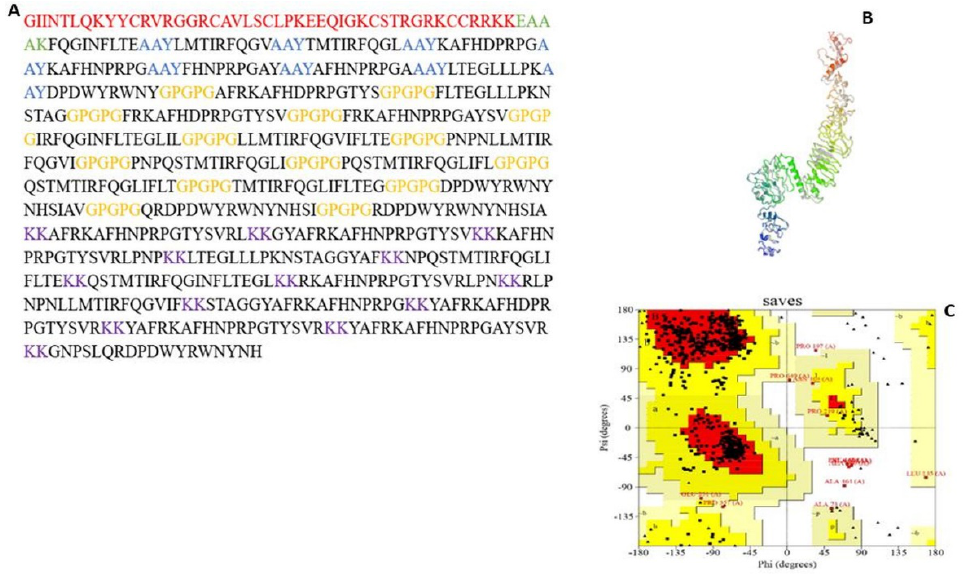
Figure 1. The 3D structure prediction and validation of MEVconstruct. ( A ) MEV construct sequence with epitopes in black; adjuvant in red; and linkers in blue, orange, green and purple. ( B ) Refined model of MEV construct. ( C ) Ramachandran analysis plot with 84.4% in most favored